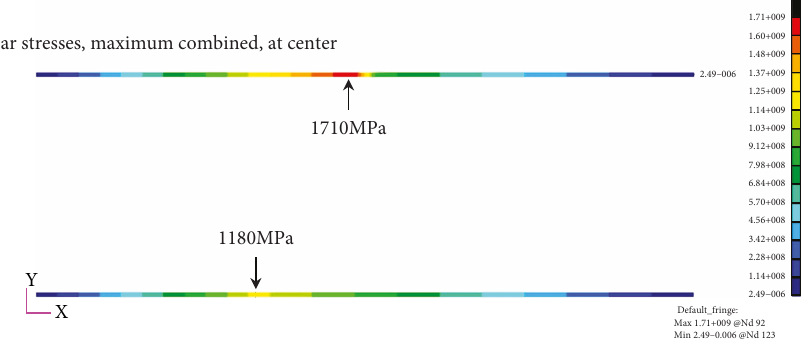
Figure 5: Stress contour plot.